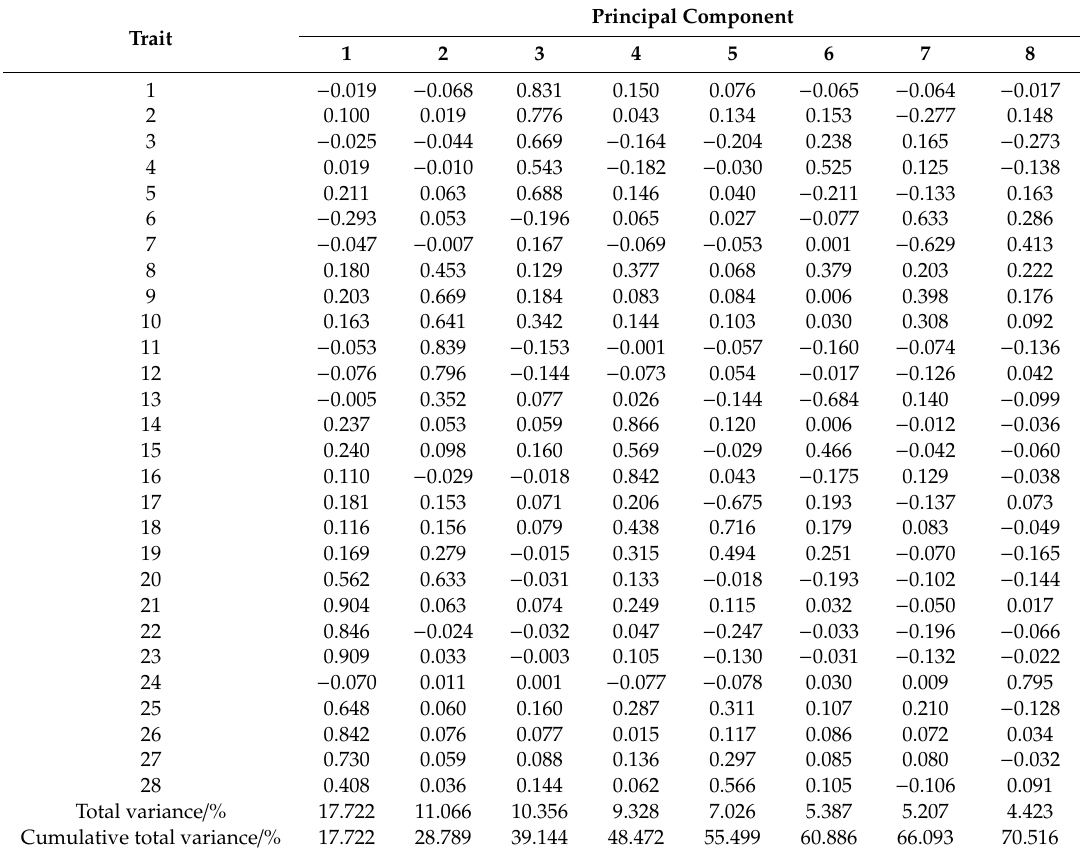
Table 5. The principal component analysis (PCA) of 28 quantitative traits.